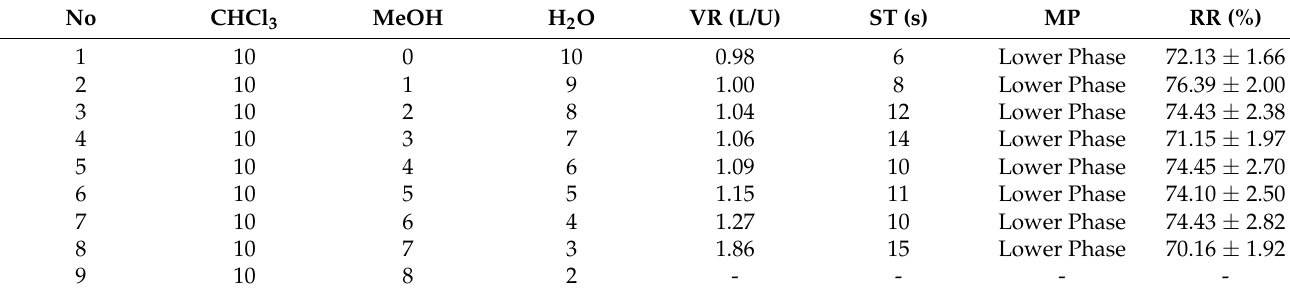
Table 3. The retention rate of chloroform–methanol–water solvent system.